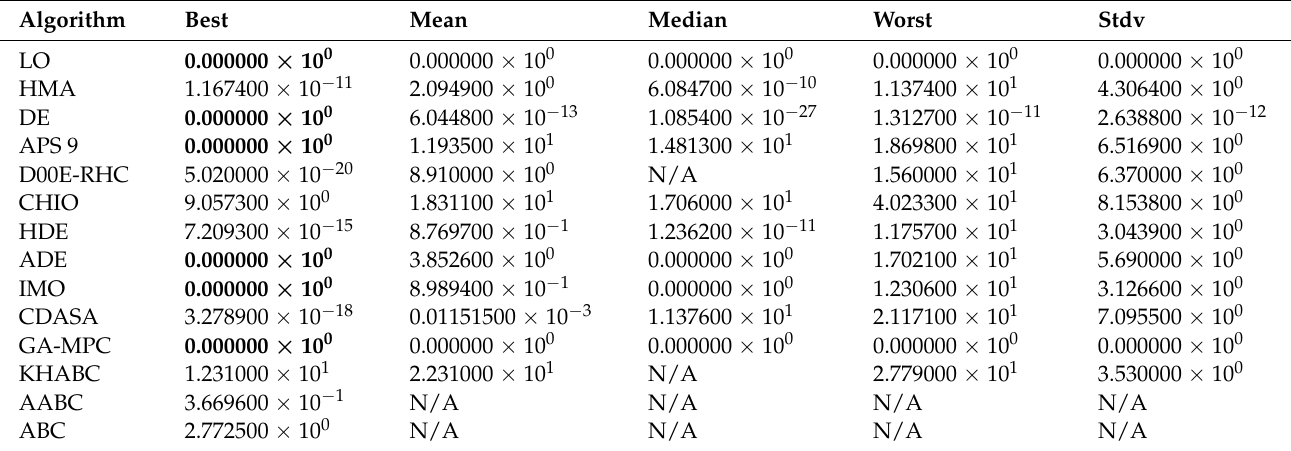
Table 10. The performance of the LO algorithm against other comparative algorithms on Parameter estimation for frequency-modulated (FM) sound waves.